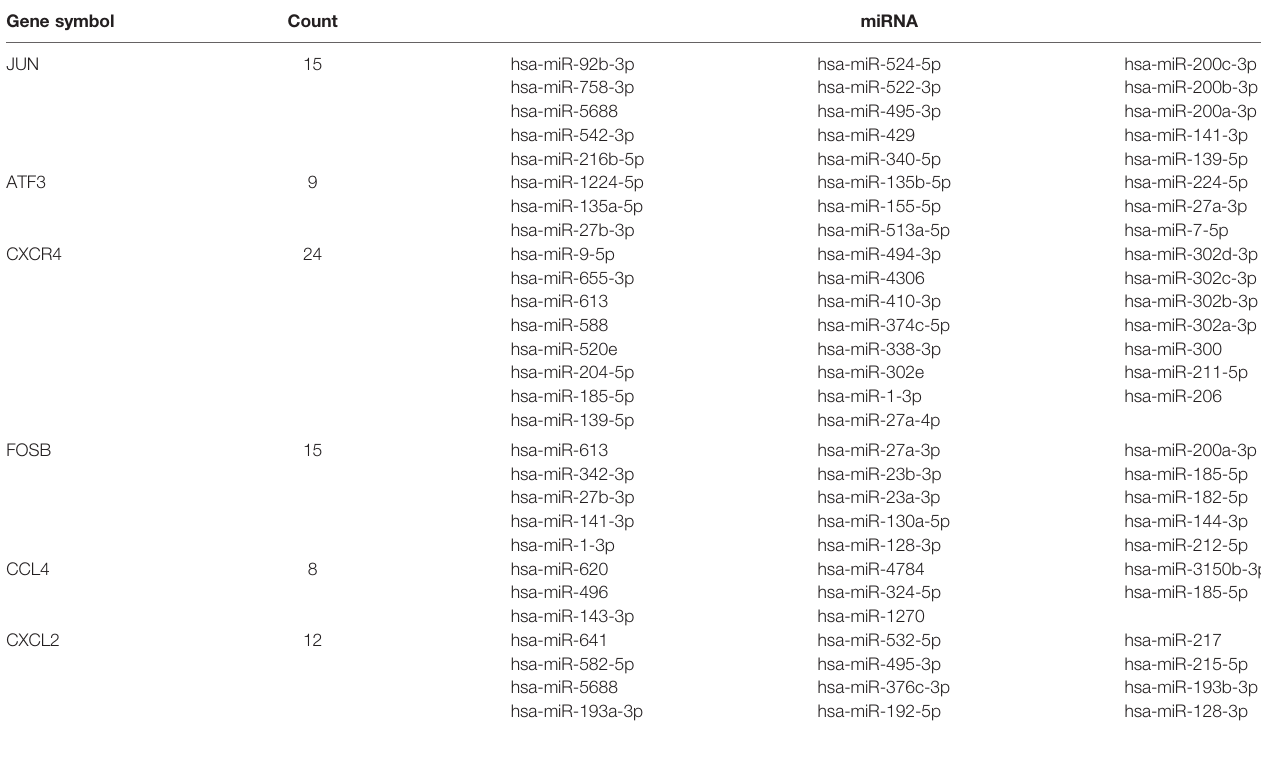
TABLE 4 | The predicted miRNA about 6